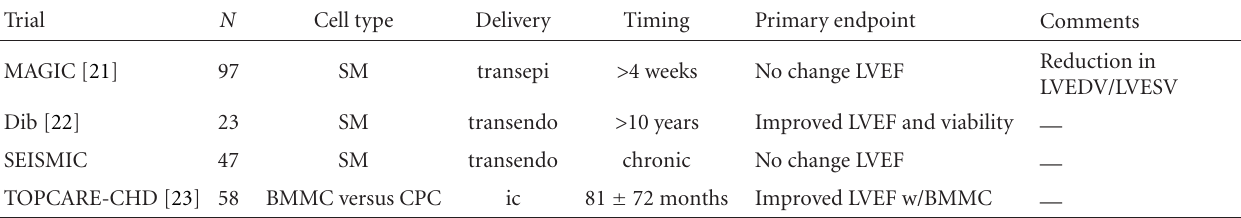
Table 3: Randomized clinical trials in patients with chronic ischemic heart failure.